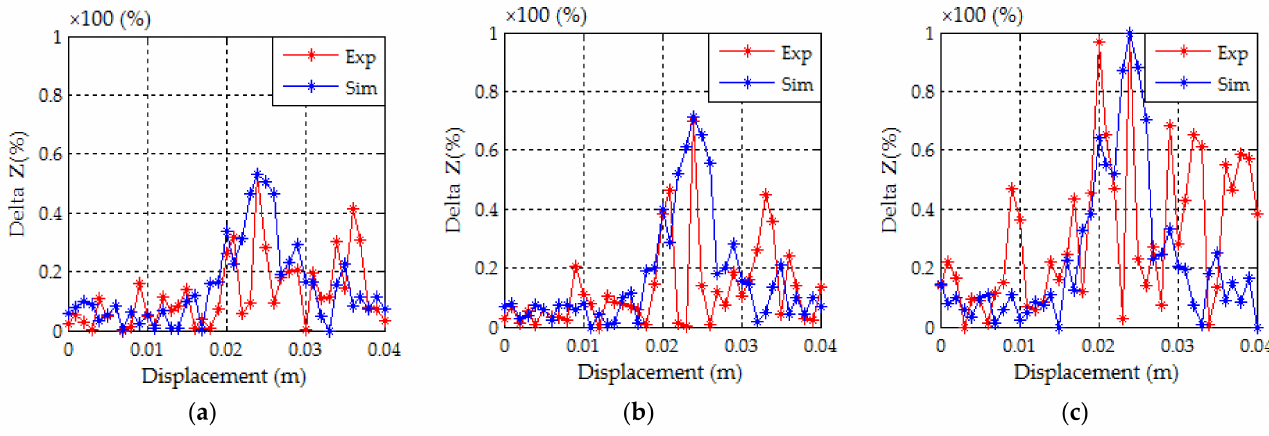
Figure 10. Impedance variation in (%) at 10 kHz with ( a ) depth = 0.3 mm, ( b ) depth = 0.5 mm, and ( c ) depth = 1 mm.